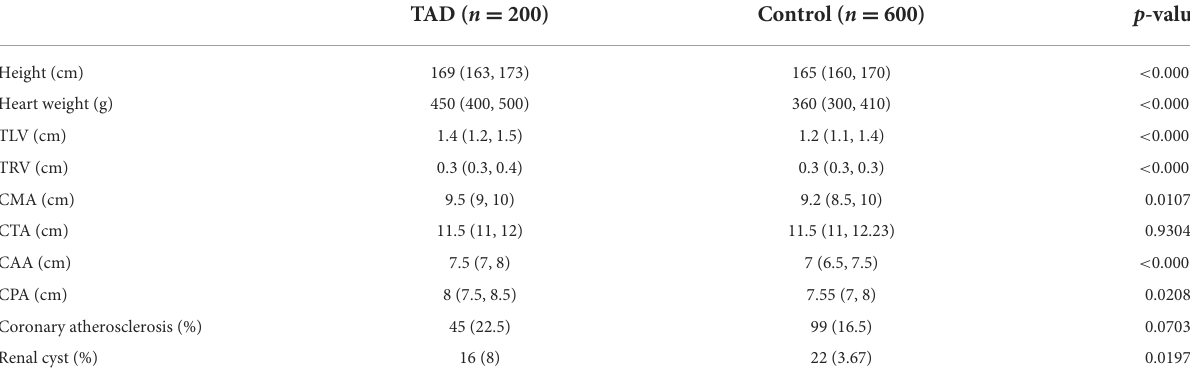
TABLE 4 Postmortem finding differences between TAD deceased and control